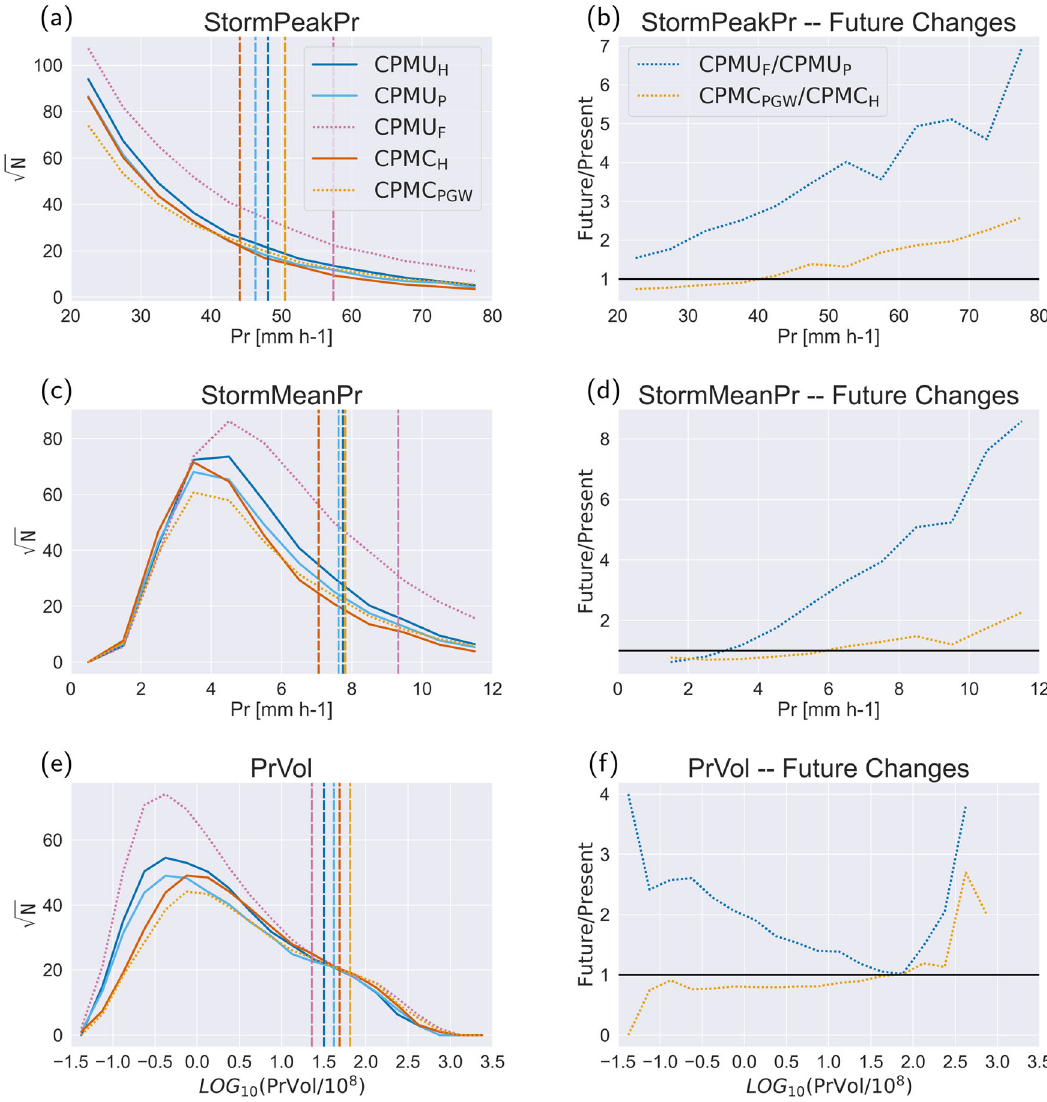
Fig. 3 Histograms of various storm properties and their future changes. Square roots of counts on a , c , e : CPMU H (cyan), CPMU P (dark blue), CPMU F (purple) CPMC H (orange), and CPMC PGW (red). Future changes as ratios on b , d , f : UKMO (purple), ETHZ (brown). The properties are a , b MCS peak intensity (StormPeakPr), c , d average precipitation rate per model grid point over the MCS (StormMeanPr), and e , f precipitation volume (PrVol). Vertical lines on a , c , e indicate the 95th percentile for each model simulation. For e , the percentage PrVol contribution from all storms exceeding PrVol 80th percentile are: 87% CPMU H , 88% CPMU P , 90% CPMU F , 86% CPMC H , and 87% CPMC PGW